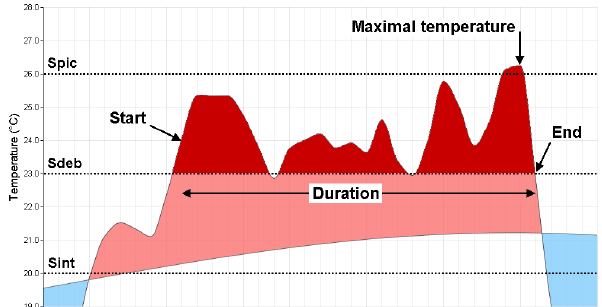
Figure 6. Principle of the characterization of a heat wave from a daily mean temperature indicator over France showing: duration (start and end) of the episode, maximal temperature and global in- tensity (red area). Temperatures above (resp. below) climatolog- ical line (1981–2010 reference period) are represented by pink (resp. blue)